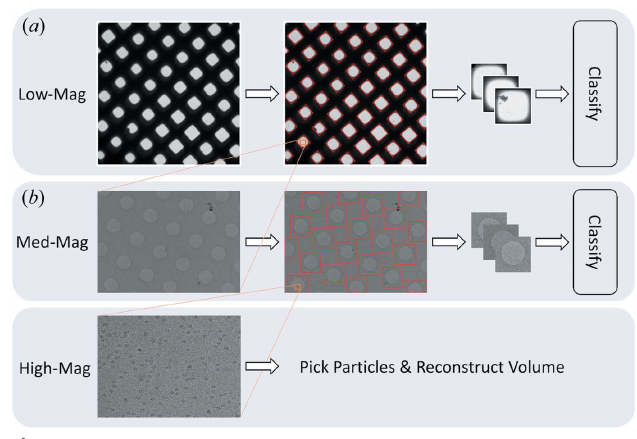
Figure 3 Pipeline overview. High-magnification images are taken from holes in medium-magnification images, which come from squares in low- magnification images. ( a ) Ptolemy detects, crops and then classifies squares in low-magnification images, which have a pixel size of approximately 200–500 nm pixel (cid:3) 1 . ( b ) Next, Ptolemy detects, crops and then classifies holes in subsequent medium-magnification images, which have a pixel size of approximately 10–100 nm pixel (cid:3) 1